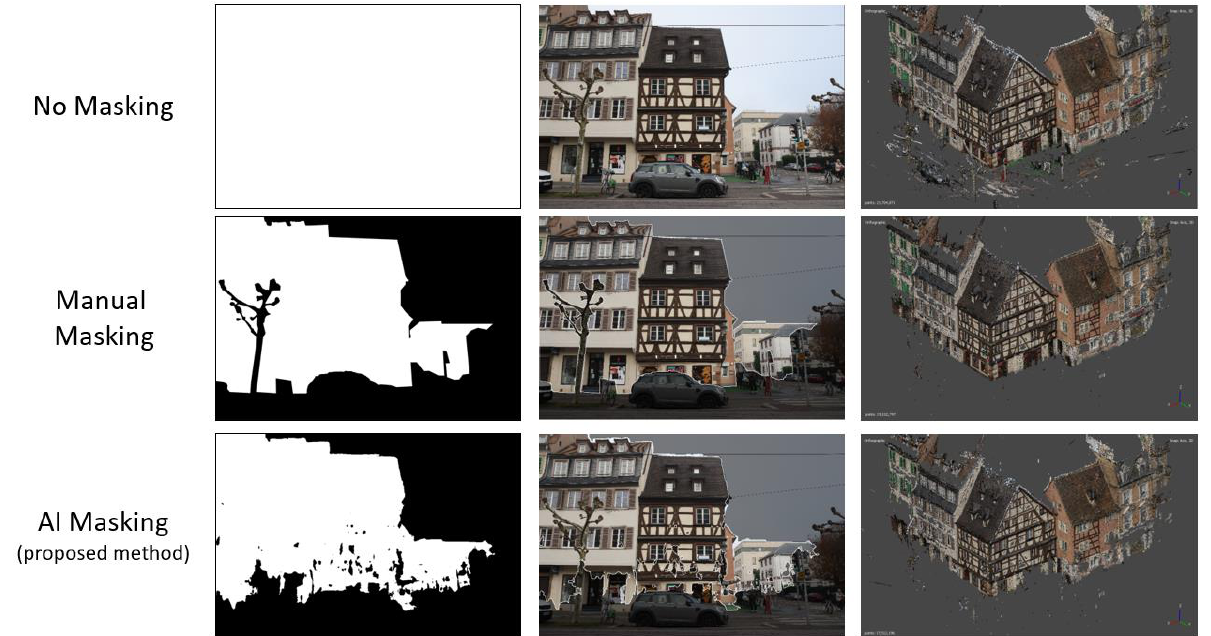
Figure 2. Illustration of the proposed workflow and comparison with traditional manual masking of unwanted objects. The third column shows the resulting dense point clouds.